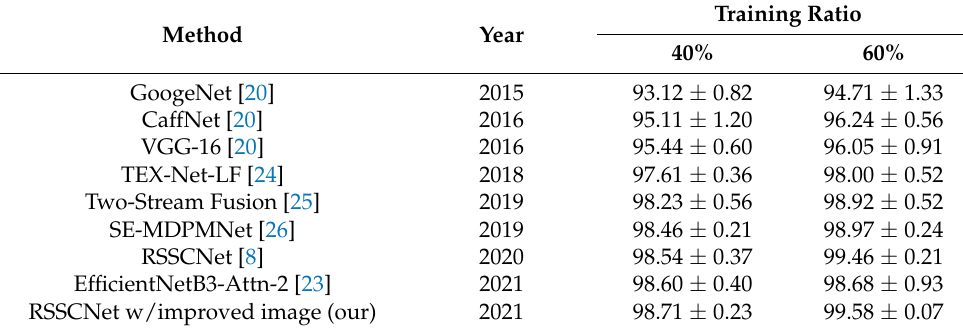
Table 10. Comparison of the overall accuracy on WHU-RS19